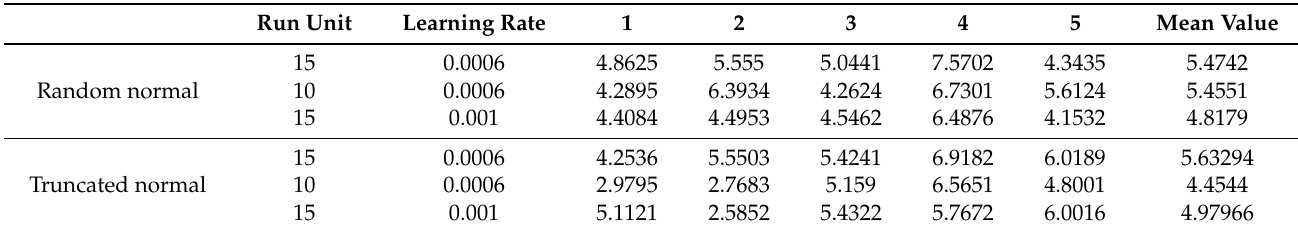
Table 7. Cross-validation of training results.